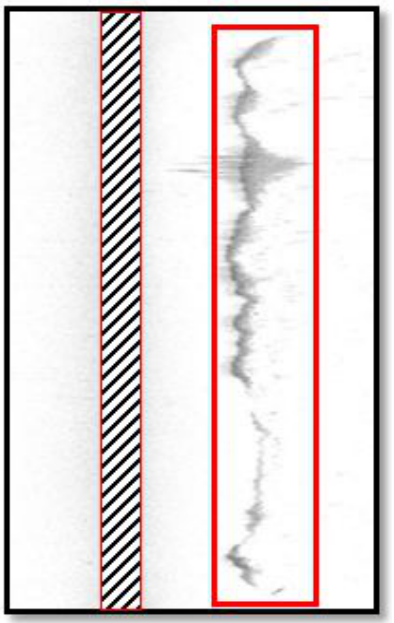
Figure 4. Backscatter image shows the hanging snag at upstream area (roughest textures)